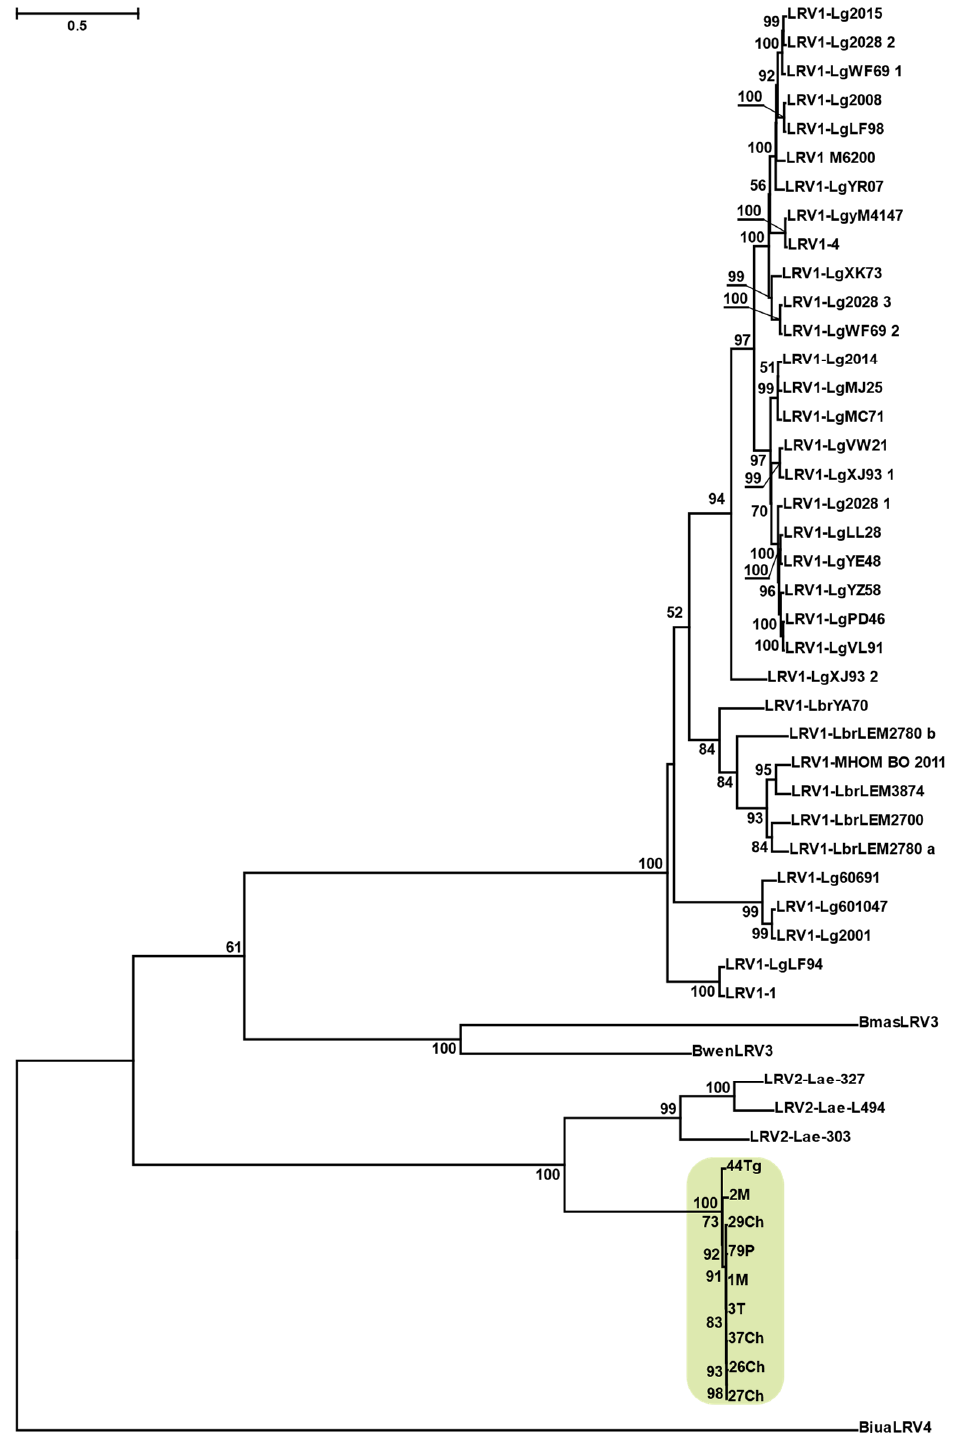
Figure 2. Maximum likelihood phylogenetic tree of leishmaniaviruses inferred using the concatenated nucleotide alignments of RDRP and capsid genes. Scale bar indicates the number of substitutions per site (please note that the evolutionary rates between different codon positions are extremely different, explaining the inferred lengths of some branches over 1). Values at branches are bootstrap supports. Isolates studied here are highlighted in green. See Table S1 for accession numbers of sequences retrieved from the NCBI.